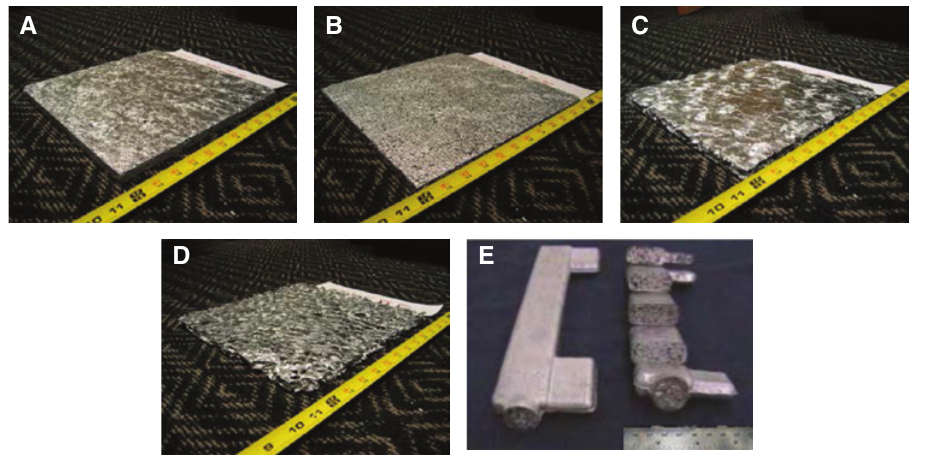
Figure 2 Morphology of different types of aluminum foam materials obtained from a commercial source: (A) a natural small cell (NSC), (B) an open one-side small cell (1SSC), (C) a natural large cell (NLC), (D) an open two-side large cell (2SLC), and (E) a sandwich composite enclosed by thicker skins (3D).